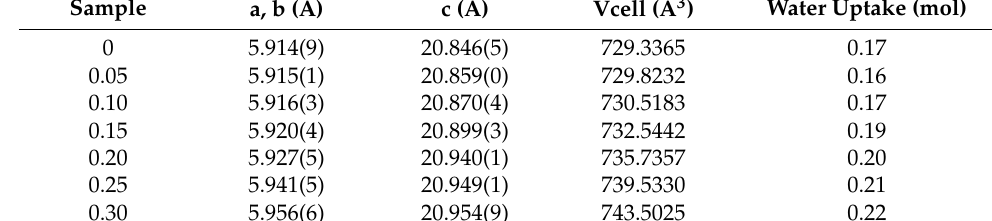
Table 2. Lattice parameters, unit cell volume, and water uptake for BaLa 2 − x Ba x In 2 O 7 − 0.5 x . Sample